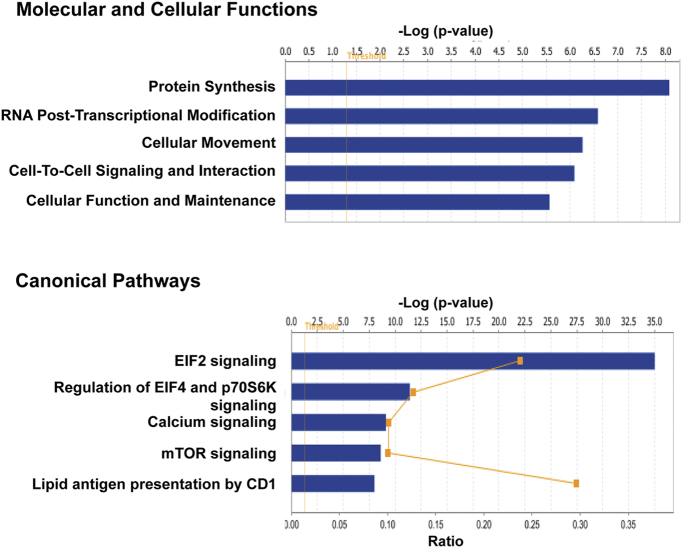
Ingenuity Pathway Analysis (IPA) to identify altered molecular and cellular functions and canonical pathways in diffuse astrocytomas.The differentially expressed proteins (n = 340) as listed in Supplementary Table S1 were used for these analyses. Top 5 molecular and cellular functions and canonical pathways are shown in the figure. Threshold criteria considered for the analysis are -log p-value > 1.3 or p-value < 0.05. The list of proteins under each category is provided in Supplementary Table S4.